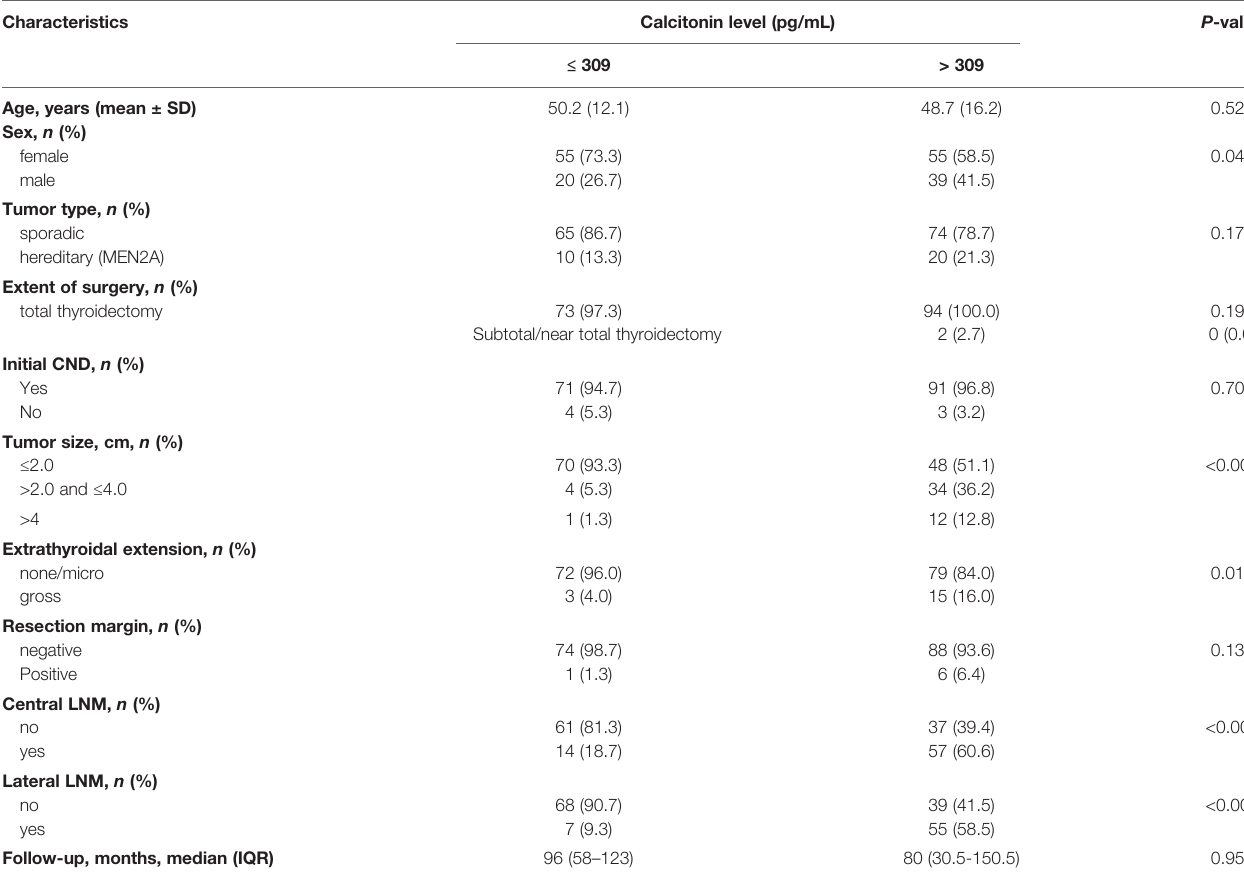
TABLE 2 | Clinicopathological characteristics according to preoperative serum calcitonin levels.